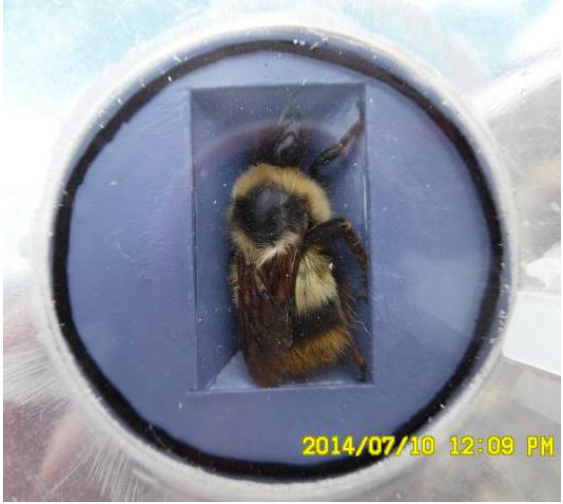
F IGURE 2. A typical photograph (Bombus balteatus queen), showing the time/date